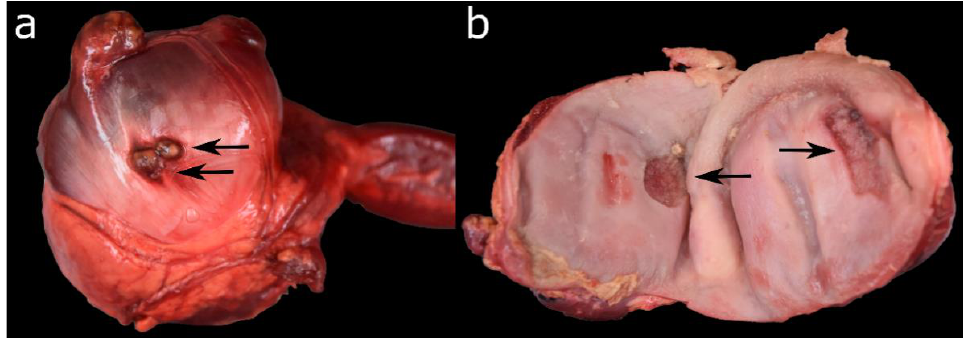
Figure 6. ( a ) Granulomatous and pyogranulomatous serositis of the gizzard. ( b ) Necrotising gastri- tis of the gizzard of the same animal.